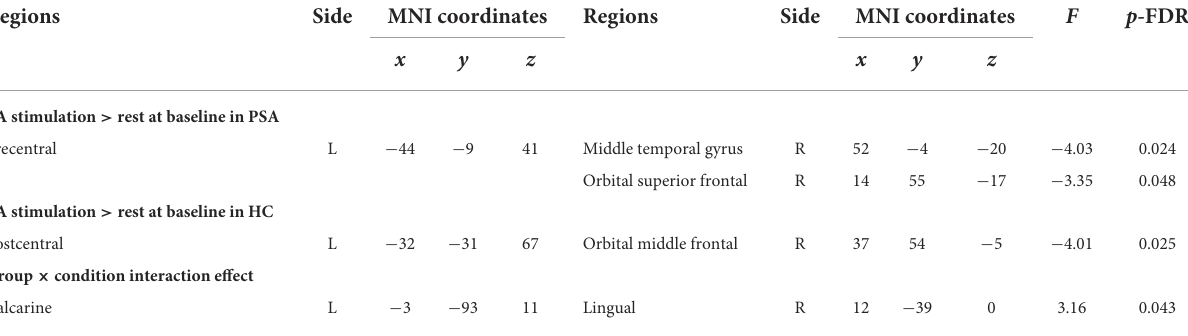
variability of occipital network LN and CN coupling (Figure 5A), with stronger connections between the LN and CN ( F = 4.29, pFDR = 0.042, uncorrected p = 0.0053), DMN and CN ( F = 4.28, pFDR = 0.043, uncorrected p = 0.005) (Figure 5B; Table 4).